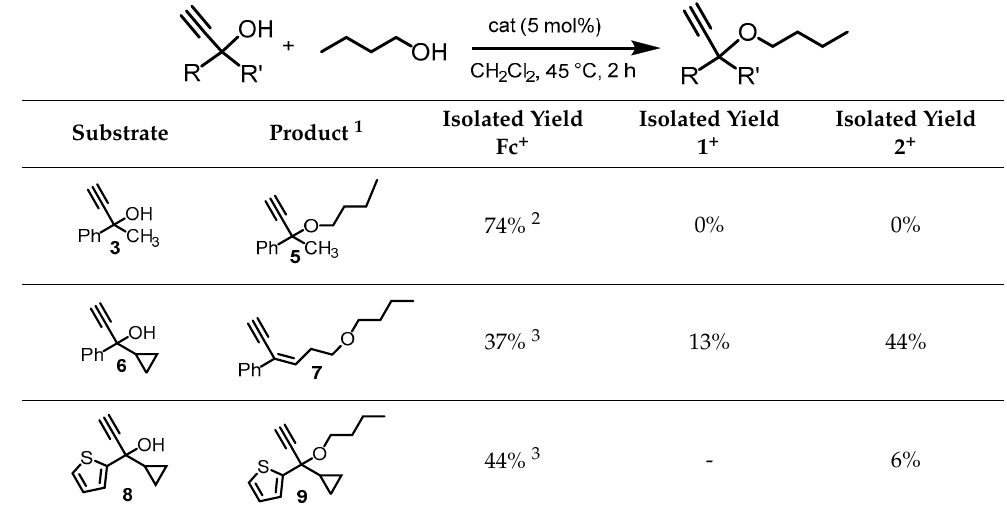
1 + SbF 6 , Figure S2: Molecular packing of the crystal, Table S1: Intermolecular interaction geometries of 1 + SbF 6 , plot of the i max value vs the square root of the scan rates, IR and UV-vis spectra of 1 + SbF